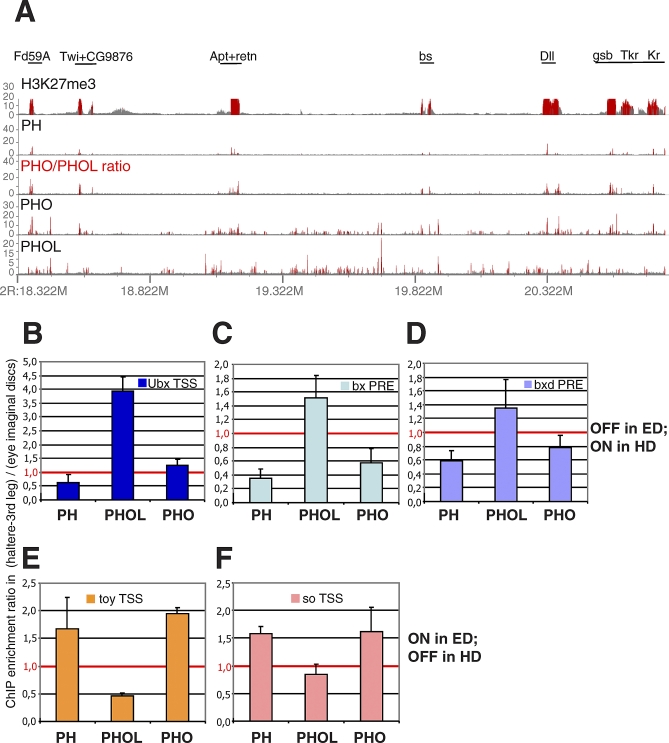
Differential PHO and PHOL Binding Ratios at PcG Target Genes in ON and OFF States(A) Profiles of H3K27me3, PH, the PHO/PHOL ratio, PHO, and PHOL are shown along part of chromosome 2R. Significantly enriched fragments (p-value <1E−04) are shown in red. Note that at PcG binding sites, the PHO/PHOL ratio is significantly increased. Apt, apontic; bs, blistered; Dll, Distal-less; fd59A, forkhead domain 59A; gsb, gooseberry; Kr, Kruppel; retn, retained; Tkr, Tyrosine kinase-related protein; Twi, twist.(B–F) ChIP-qPCR performed with PH, PHO, and PHOL antibodies of haltere/third leg imaginal discs (HD) and eye imaginal discs (ED). Ubx is expressed in haltere/third leg imaginal discs and is repressed in eye imaginal discs. so (sine oculis) and toy (twin of eyeless) both show low expression levels in haltere/third leg imaginal discs and are highly expressed in eye imaginal discs. The ChIP yield (qPCR) of the examined regions was normalized to input DNA and an internal control (robo3). Data are expressed as the ratio of ChIP enrichments in haltere/third leg discs versus eye discs. The standard deviation, as indicated by the error bars, was calculated from three independent experiments. At the Ubx gene (B–D), a small decrease in the levels of PH was detected in haltere/third leg discs compared to eye discs. Lower levels of PH in haltere/third leg discs correlated with a lower PHO/PHOL ratio. In contrast, slightly higher levels of PH binding were detected in haltere/third leg discs at so and toy (E and F), which are repressed in these discs. Higher levels of PH in haltere/third leg discs correlate with a higher PHO/PHOL ratio.